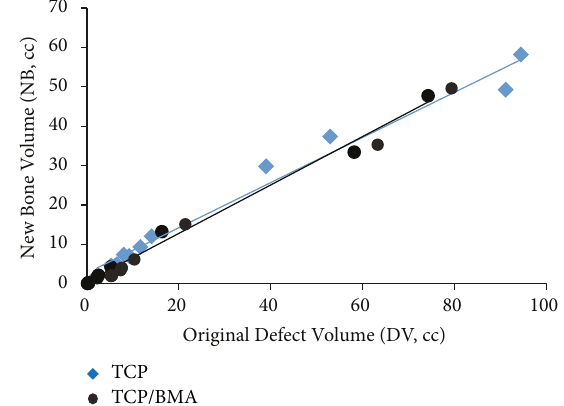
Figure 8: New bone volume (NB) as a function of original defect volume (DV) for the TCP and TCP/BMA groups. Linear regression lines through the two groups are also